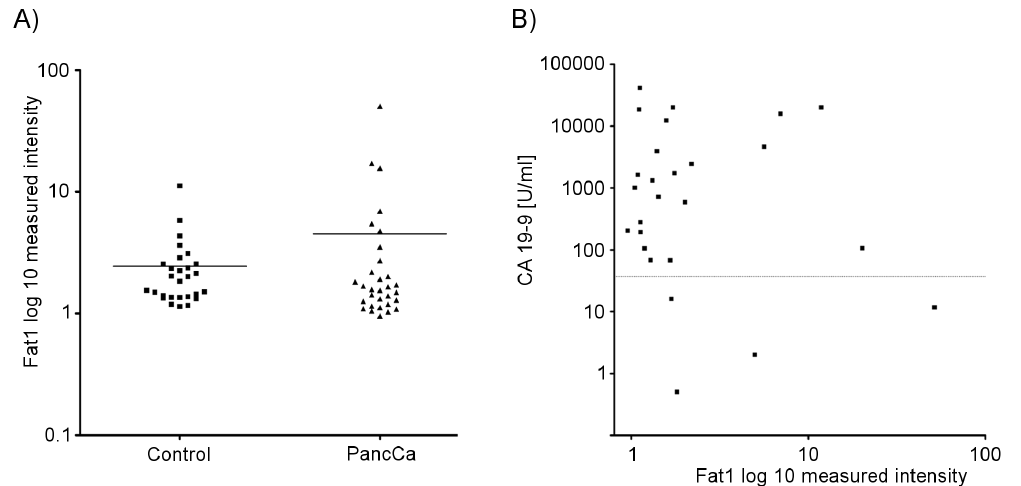
Figure 11. Serum level of soluble Fat1 in patients with pancreatic cancer. A) Levels of soluble Fat1 in serum as determined by ELISA (see Methods). Serum samples from 28 unaffected individuals are compared to the levels of Fat1 in 31 patients with pancreatic cancer (listed in table S4). B) Comparison of circulating Fat1 with CA19-9 levels in patients with pancreatic cancer. Samples are the subset of 26/30 patients with CA19-9 levels